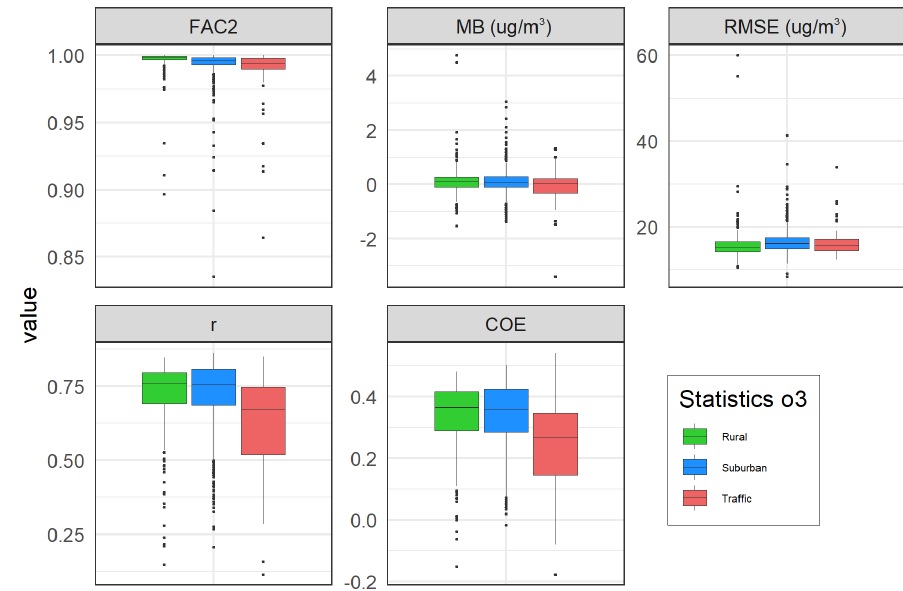
Figure 7. Box plots of evaluation parameters from the cross-validation for 2005–2019 (again for the same three types of stations).